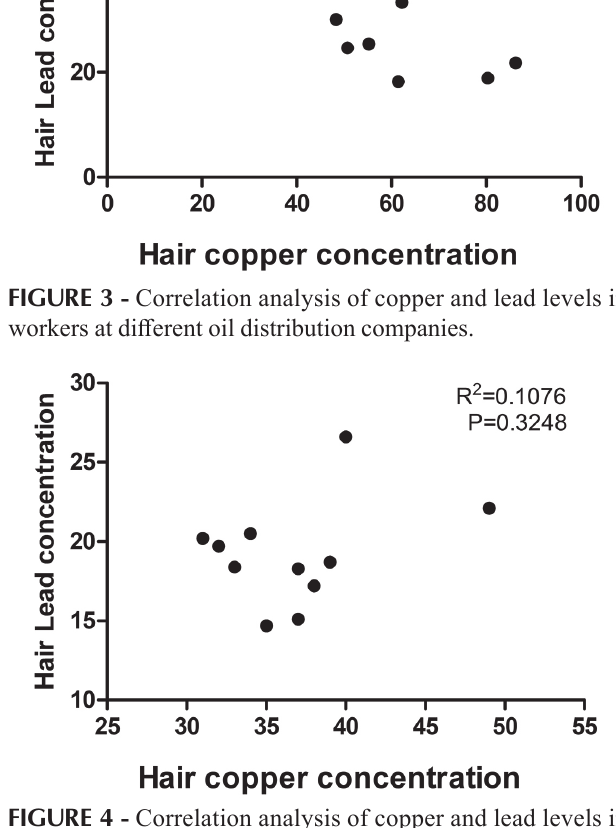
FIGURE 4 - Correlation analysis of copper and lead levels in normal control